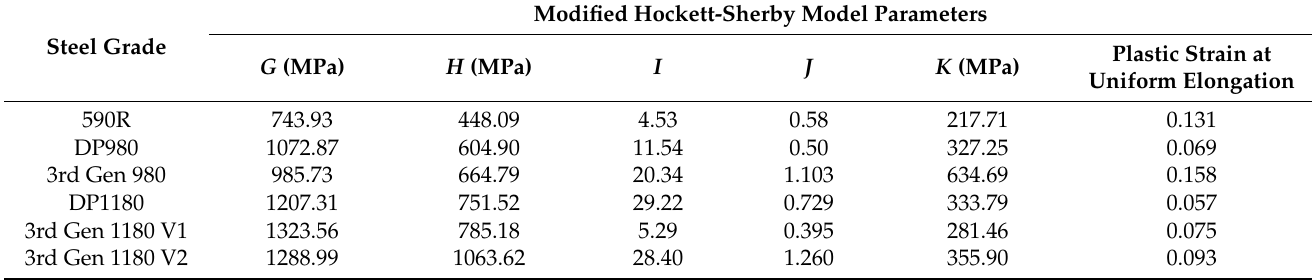
Table 3. Calibrated coefficients for the MHS hardening model in the RD. Note that the data for the DP1180 was published in Butcher et al. [14], for the DP980 in Noder and Butcher [21], and for the 3rd Gen 1180 V1 and 3rd Gen 980 in Gutierrez et al. [12]. The conversion factor from RD to TD was obtained using the measured stress ratios.